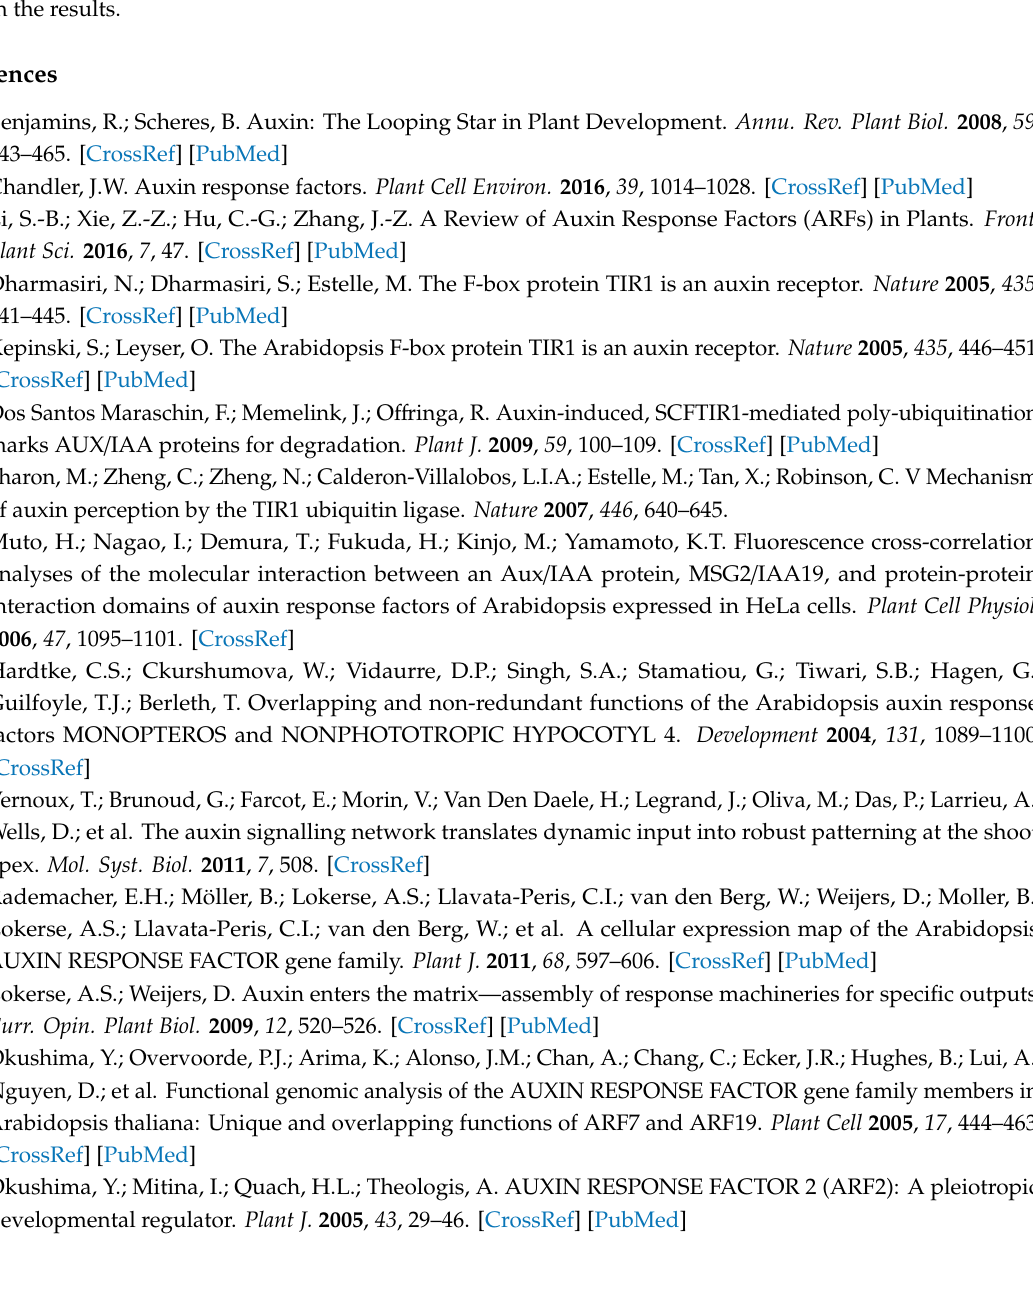
Figure S1: Negative control in-situ RNA hybridization results using dig-labelled ARF4 sense strand transcripts as probes, Figure S2: Relative expression levels of assessed ARF genes and the IAA1 gene in leaf